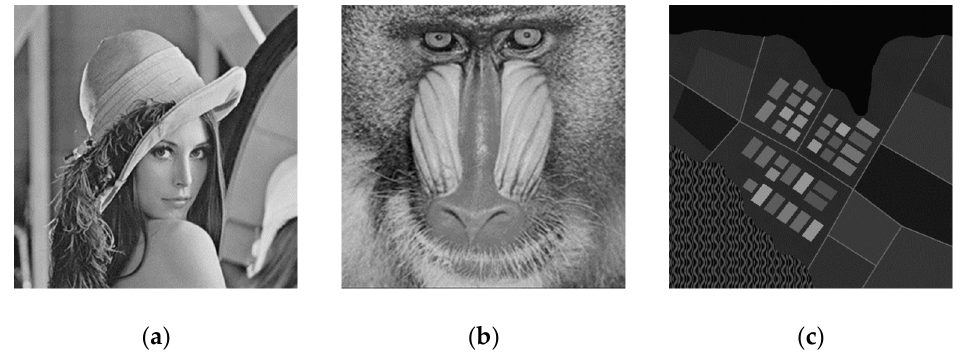
Figure 5. Test images Lenna ( a ), Baboon ( b ), and RSA ( c ).